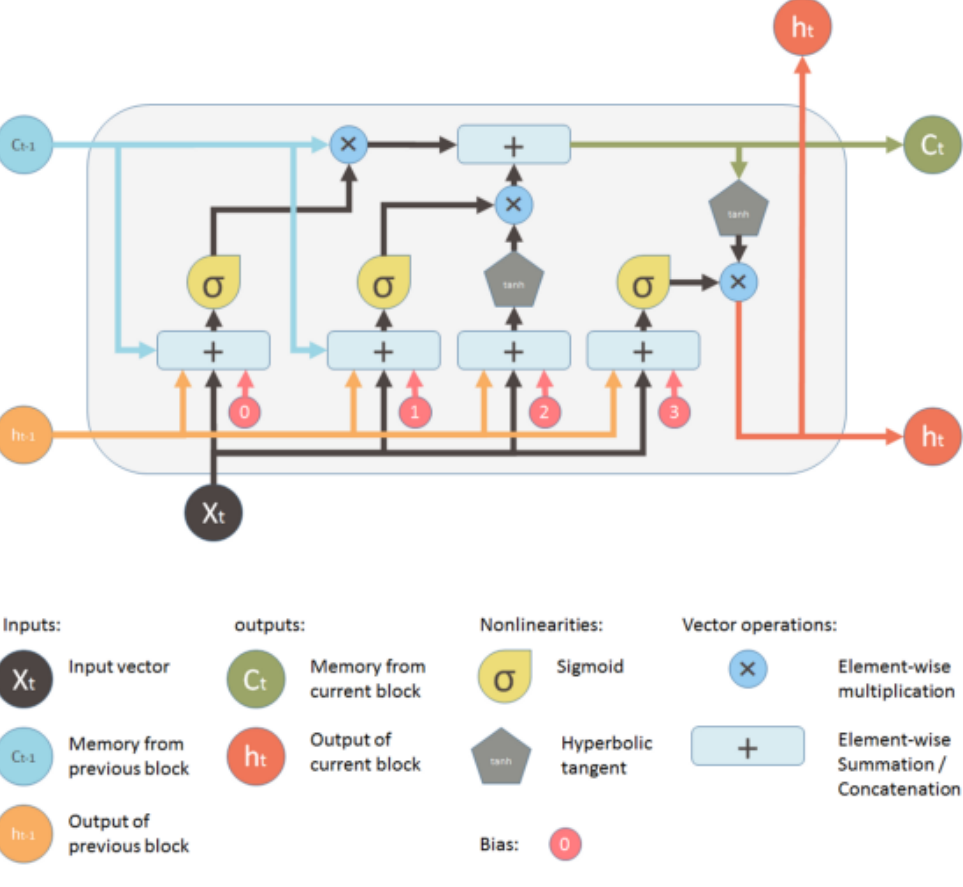
Figure 6. Architecture of LSTM model